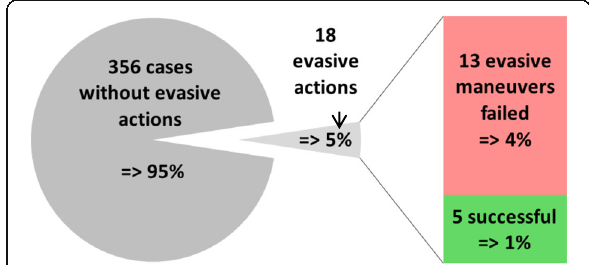
Fig. 13 Main areas of accident types involving difficult weather